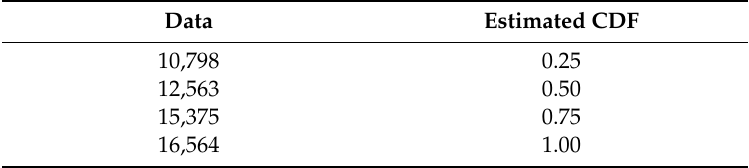
Table 3. Example of empirical cumulative distribution function (CDF)